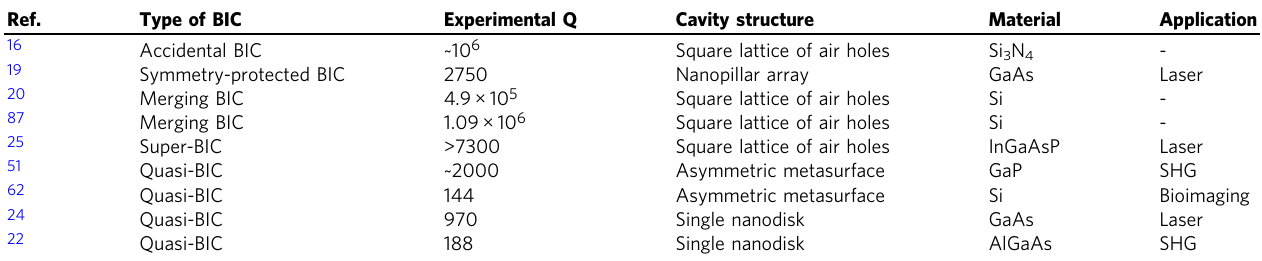
Table 1 Measured Q factors of various BICs in different platforms. SHG stands for second-harmonic generation.